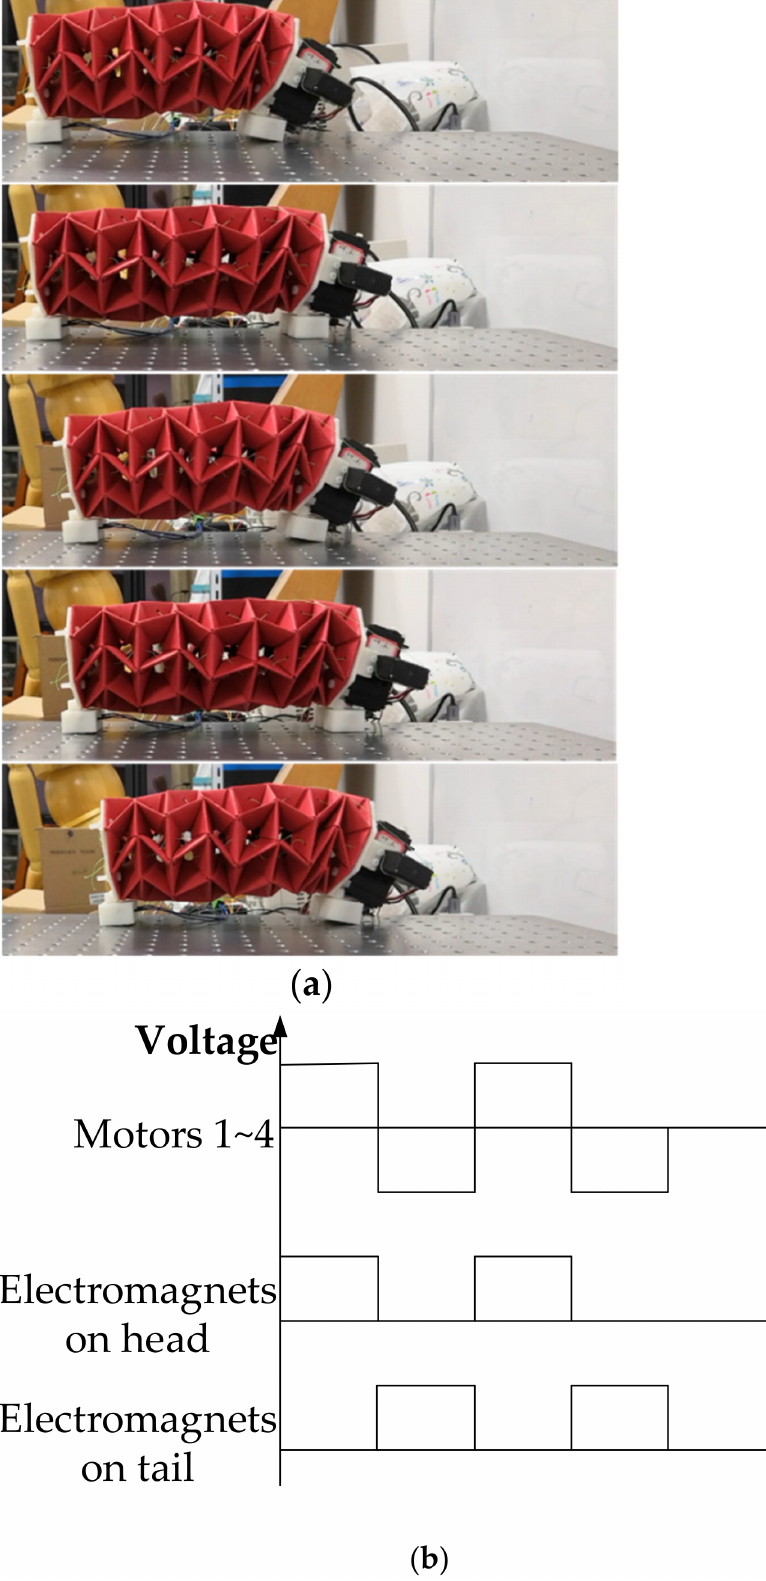
Figure 20. Origami crawling robot with electromagnetic sliding feet on an iron plane: ( a ) side view of forward motion; ( b ) control signals of motors and electromagnets of forward